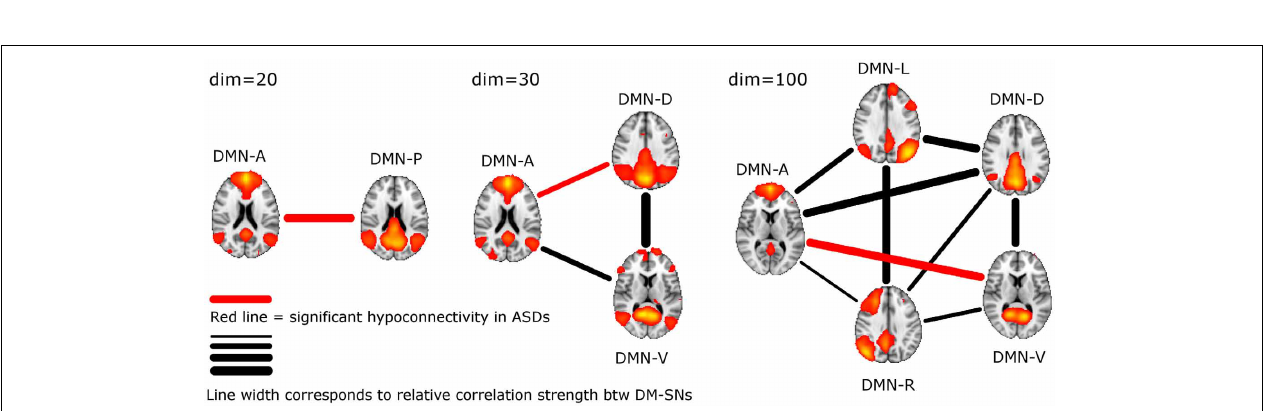
anterior and posterior SNs and then the posterior SN is further split into dorsal and ventral components. At high dim = 100 clearly lateralized DMNs appear.